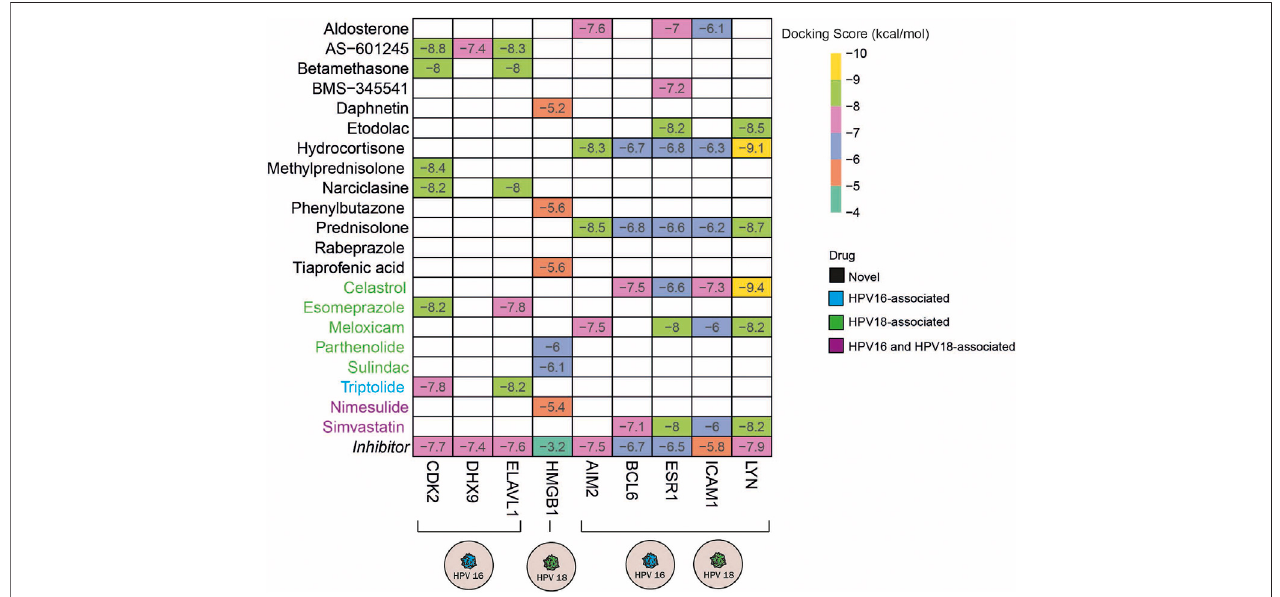
FIGURE 6 | The heatmap indicates the docking scores of the repurposed drugs. Only values with a lower docking score than the drug ’ s inhibitor are represented. The drugs colored in blue, green, and purple means the culminated drugs have been associated with HPV16, HPV18, HPV16, and 18 subtypes of cervical cancer